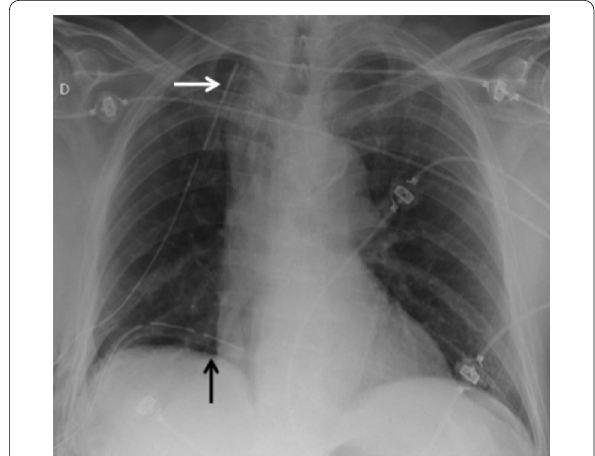
Fig. 2 Post‑operative radiograph of a right lower lobe resection. CXR allows visualisation of the drains in postero‑basal (black arrow) and antero‑apical (white arrow) positions